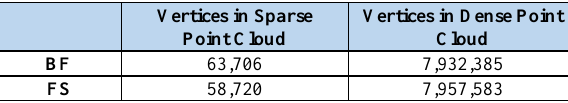
Table 1: Results from Agisoft Photoscan